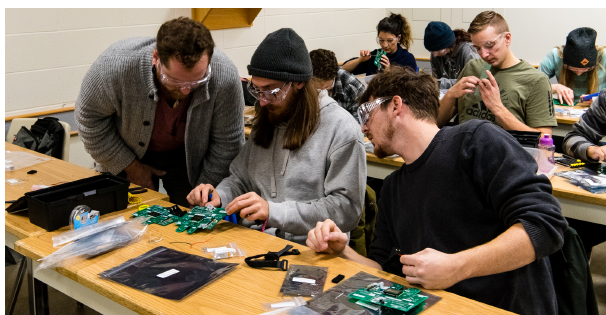
Figure 6. Example images of circuit assembly in the class. The students are using battery-operated soldering irons to solder com- ponents to the